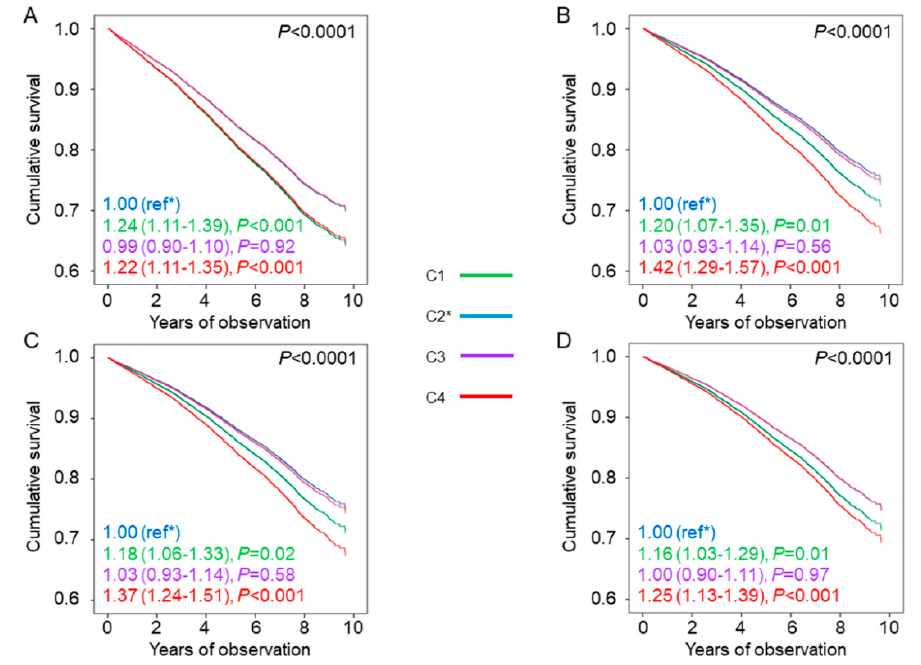
Figure 2. Mortality risk by HbA 1c categories and use of agents causing hypoglycaemia . Cox proportional hazards regression according to HbA 1c categories among participants treated with agents causing hypoglycaemia, unadjusted ( A ) and adjusted for age and gender ( B ), plus CVD risk factors ( C ), plus complications/comorbidities ( D ). HRs (95% CI) for mortality are shown for each HbA 1c category. HbA 1c = haemoglobin A 1c ; HR = hazard ratio; CI = confidence interval; C1 = HbA 1c < 6.5%; C2 = HbA 1c 6.5–7.49%; C3 = HbA 1c 7.5–8.49%; C4 = HbA 1c ≥ 8.5%.